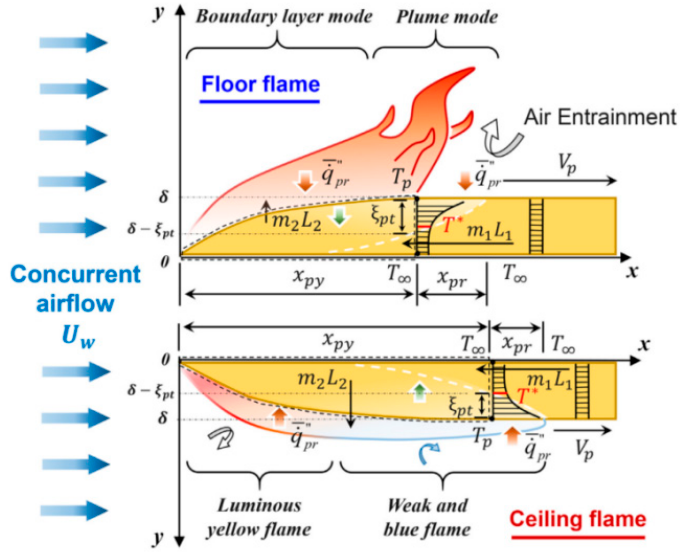
Figure 16. The concurrent floor and ceiling flame spread models Figure 20. The concurrent floor and ceiling flame spread models [98].